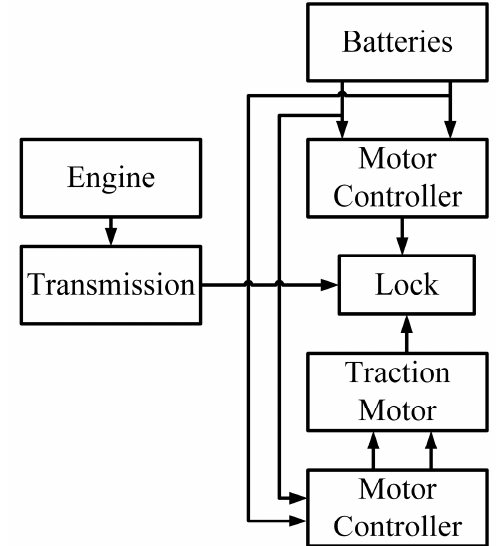
Figure 22. Drive train of series-parallel hybrid system using transmotor. The planetary gear system is absent in this arrangement [30].